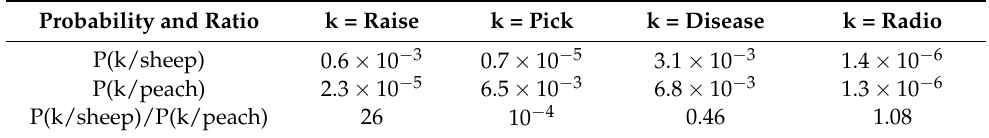
Table 1. Two non-discriminative words in our dataset. Probability and Ratio k = Raise